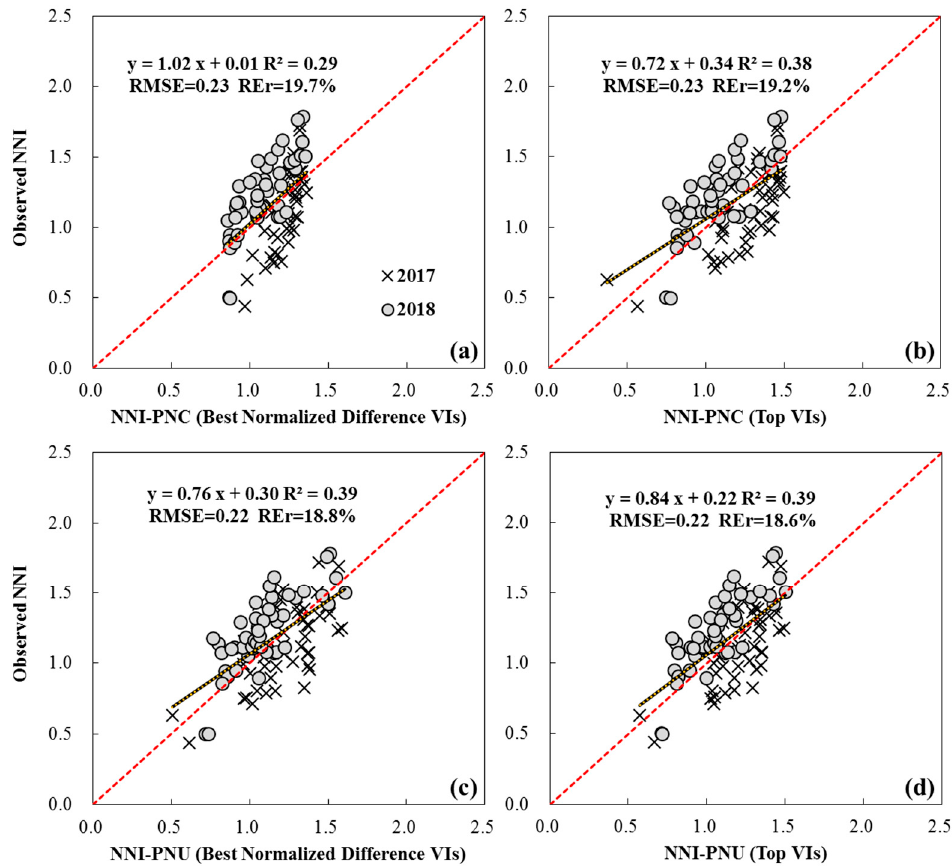
Figure 4. Validation results of nitrogen nutrition index (NNI) for two di ff erent indirect nitrogen status diagnostic approaches (NNI-PNC in a and b; NNI-PNU in c and d) using the optimal estimation model of normalized di ff erence VIs ( a ; c ) and the top vegetation indices (VIs) ( b ; d ) across varieties and years. AGB, PNC and PNU were estimated using NDVI, GNDVI and NDRE within the group of the normalized di ff erence VIs, and all of the top three performing VIs selected from the 59 tested VIs. Black lines indicate the regression line, and red dotted lines indicate the 1:1 lines.